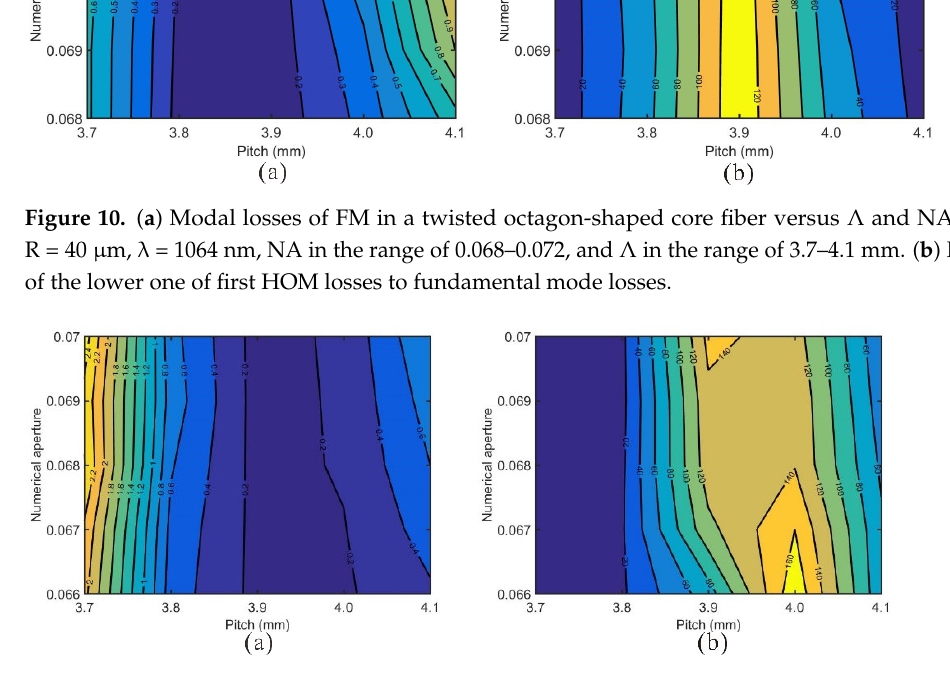
Figure 11. ( a ) Modal losses of FM in a twisted heptagon-shaped core fiber versus Λ and NA with R = 40 μm, λ = 1064 nm, NA in the range of 0.066–0.07, and Λ in the range of 3.7–4.1 mm. ( b ) Ratios of the lower one of first HOM losses to fundamental mode losses.